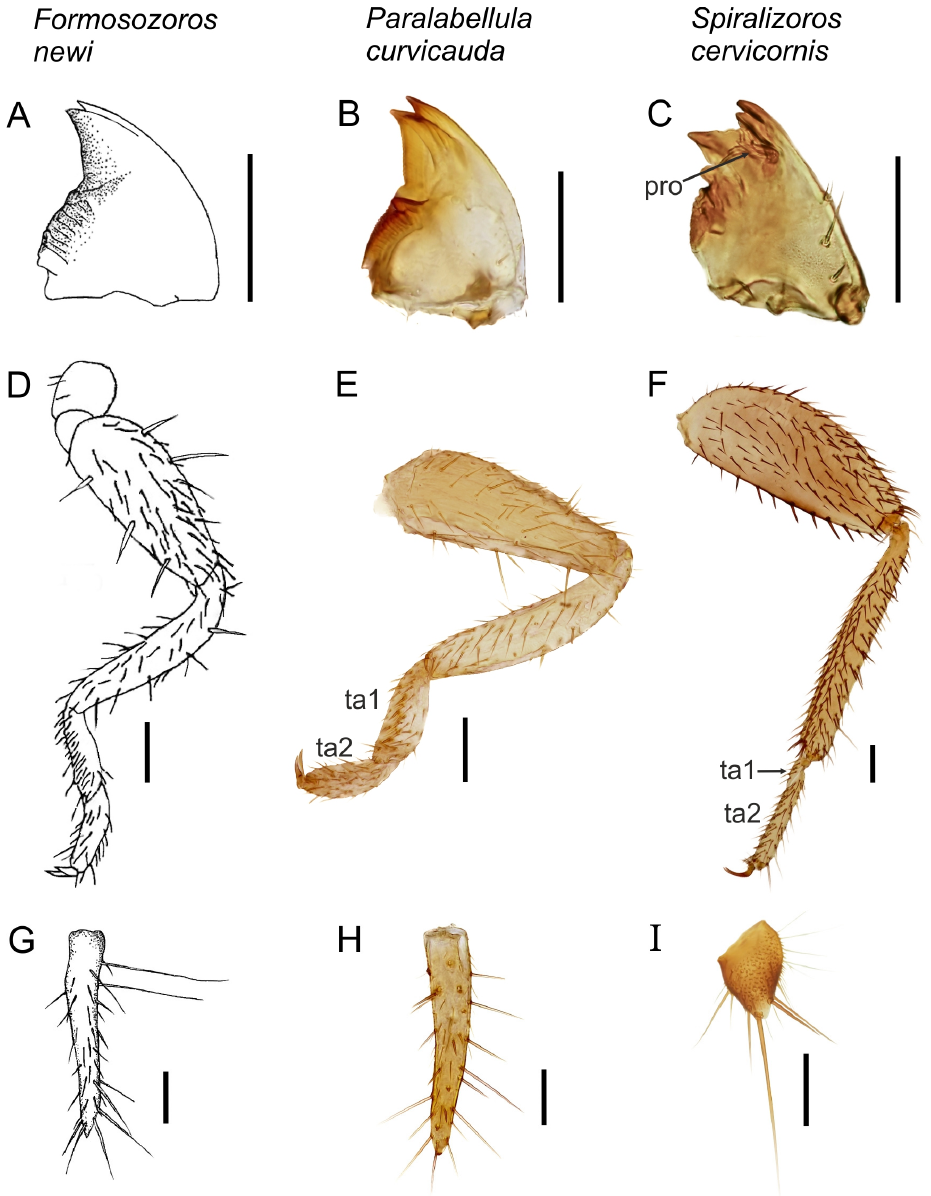
Figure 2. Comparison of diagnostic morphological structures among Formosozoros newi (Chao & Chen, 2000) ( A , D , G ), the nymph of Paralabellula curvicauda (Motschulsky, 1863) ( B , E , H ), and the adult of Spiralizoros cervicornis (Mashimo, Yoshizawa & Engel, 2013) ( C , F , I ). Ventral views of the left mandible of F. newi ( A ), P. curvicauda ( B ), and S. cervicornis ( C ). Dorsal views of the right hind leg of F. newi ( D ), P. curvicauda ( E ), and S. cervicornis ( F ). Dorsal views of the right cercus of F. newi ( G ), P. curvicauda ( H ), and S. cervicornis ( I ). pro — prostheca; ta1 — 1st tarsomere; ta2 — 2nd tarsomere. Drawings of Formosozoros newi ( A , D , G ) are redrawn from the original description (Chao & Chen, 2000) with permission from Pan ‐ Pacific Entomologist, published by the Pacific Coast Entomological Society. Scale bars = 0.1 mm.